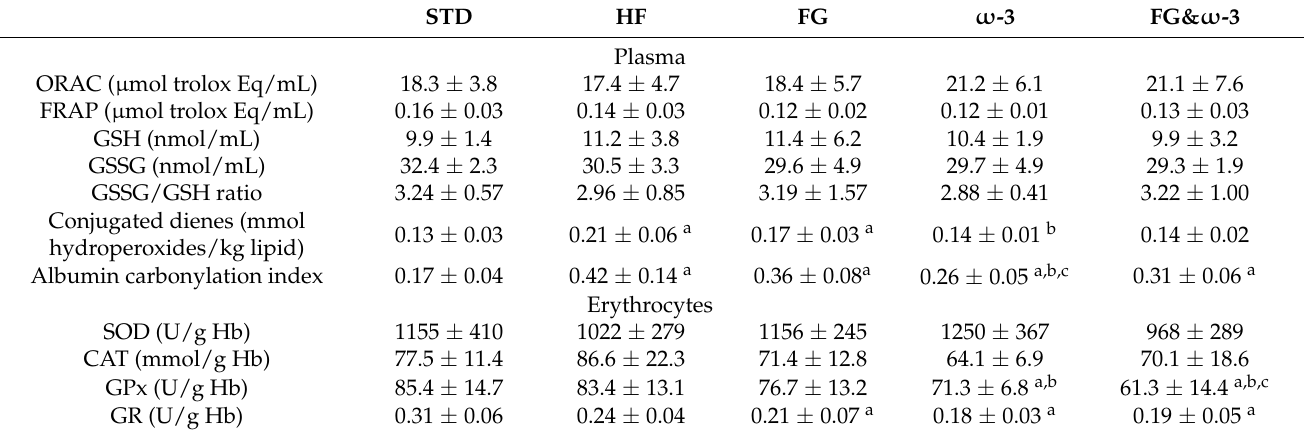
Table 2. Oxidative stress biomarkers in blood after 21 weeks of dietary